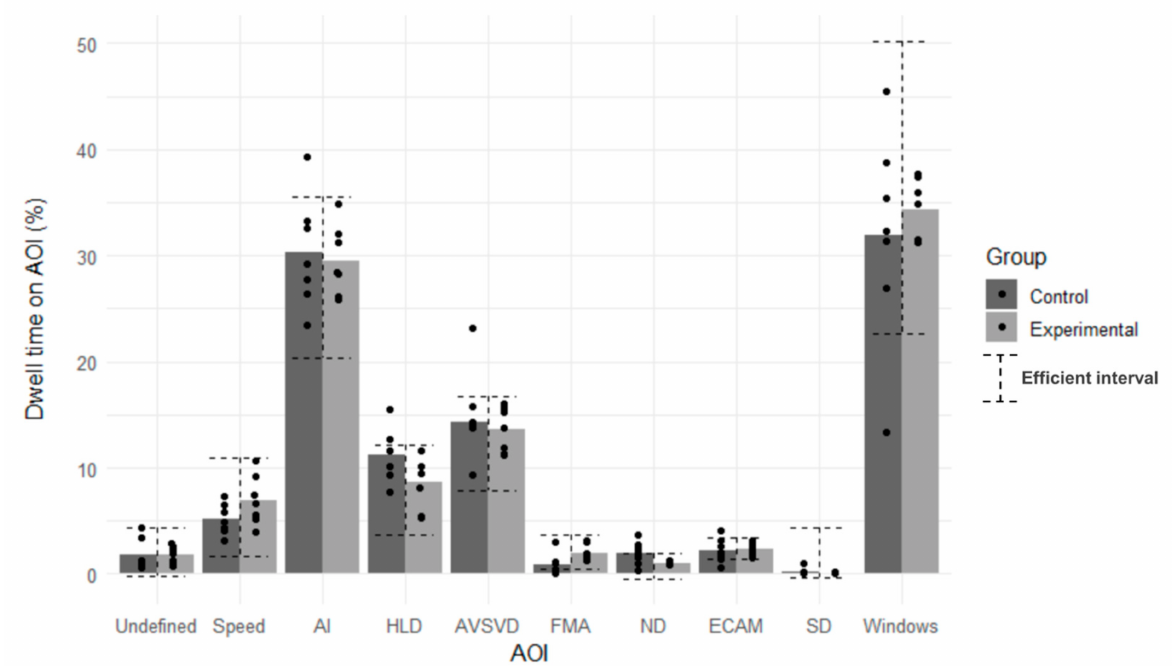
Figure 12. Percentage of dwell times on each cockpit AOI for the control and experimental groups (dots represent individual data). Undefined = undefined locations plus loss of gaze: the value is low, showing the high quality of the eye-tracking data and the fact that few fixations occurred outside the defined AOI. The dashed error bars indicate the interval spanning over the mean percentage of dwell times on each AOI for the accurate pilots plus/minus two standard deviations (as measured during the pre-training